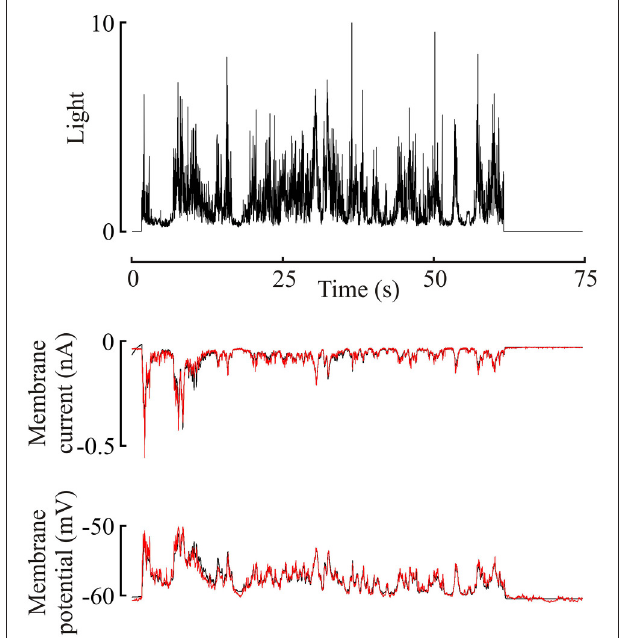
FIGURE 2 | Membrane current and potential changes in a Periplaneta photoreceptor during 60s naturalistic light stimulation ( van der Schaaf and van Hateren, 1996 ). Light stimulus in the upper trace, with membrane current and potential in the middle and lower traces, respectively. This light level gave an estimated mean response of 620 ep/s. Experimental current and potential (black) are plotted with superimposed responses from the model of Figure 1 to the same stimulus (red), using the best-fitting parameters for this data. Note, that model data reproduces experimental data well-enough to obscure most of the underlying (black)